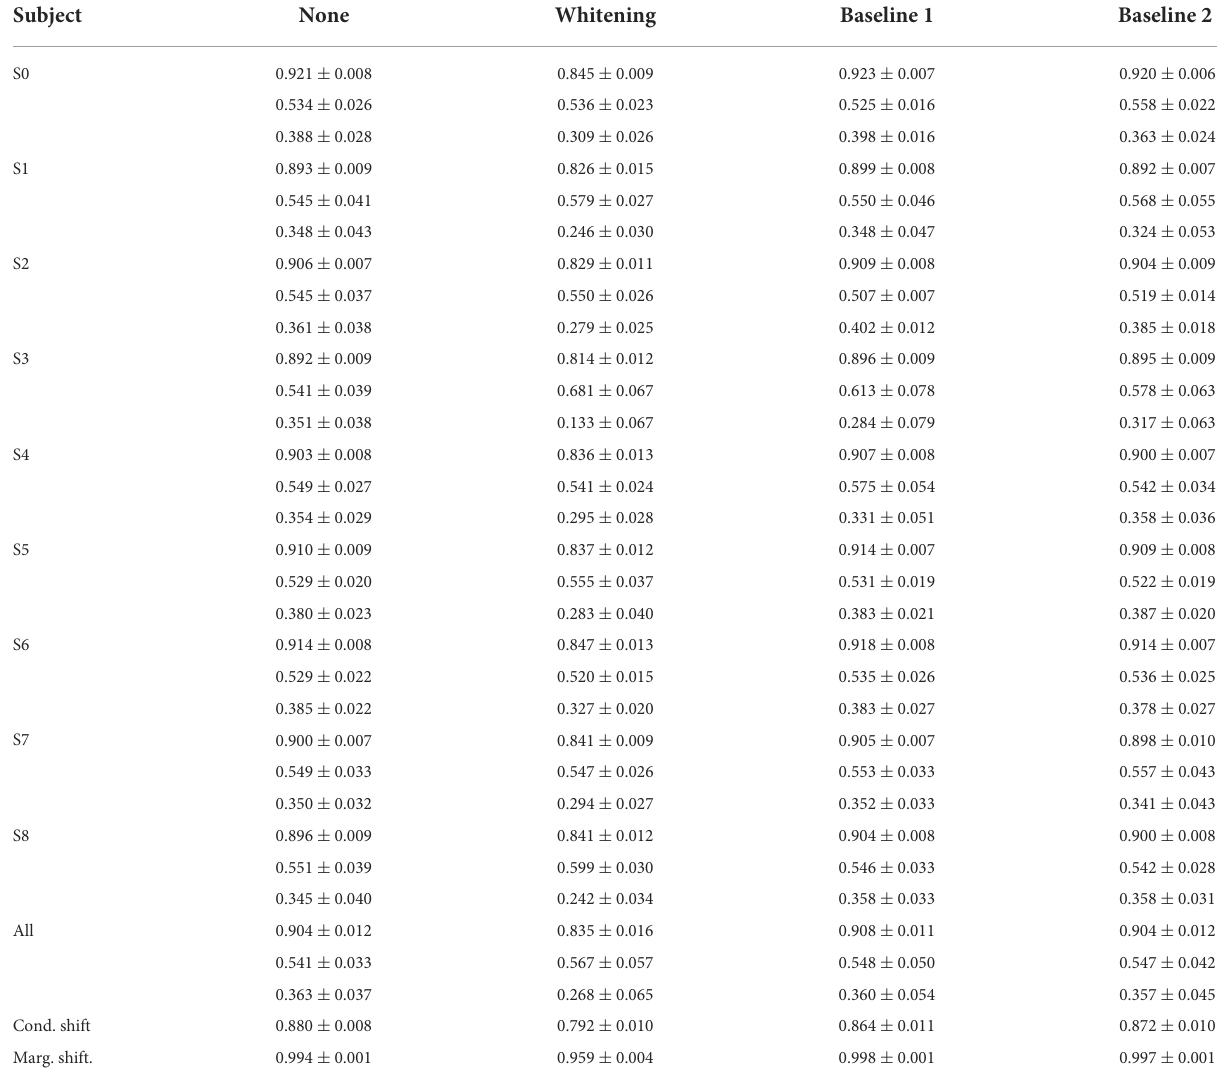
TABLE 2 Results of binary mental workload classification with leave-one-subject-out cross validation for subjects that performed physical activity on the